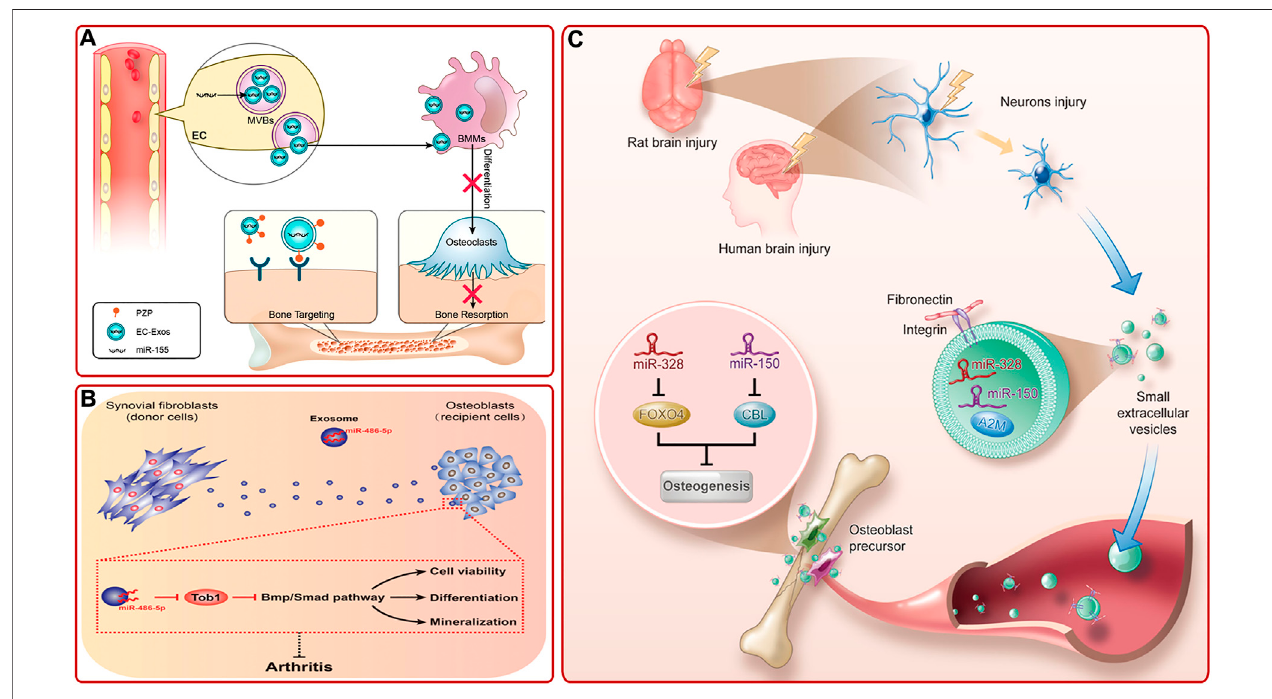
FIGURE 7 | (A) Diagram of bone targeting and functional EC-exos (Song et al., 2019). (B) FLSs-exos carrying miR-486-5p inhibited Tob1 to activate the BMP/ Smadsignaling pathway, thus enhancingosteoblast proliferation, mineralization, and differentiation, thenalleviatingRA(Chen J.etal., 2020). (C) Schematic mechanism ofbone healingaccelerated bythedamagedbrain.Damaged neuronsreleased exosomes,whichwererich inmiR-328a-3p and miR-150-5p.Theycouldtarget FOXO4 and CBL and thus promoted osteogenesis (Xia et al., 2021).